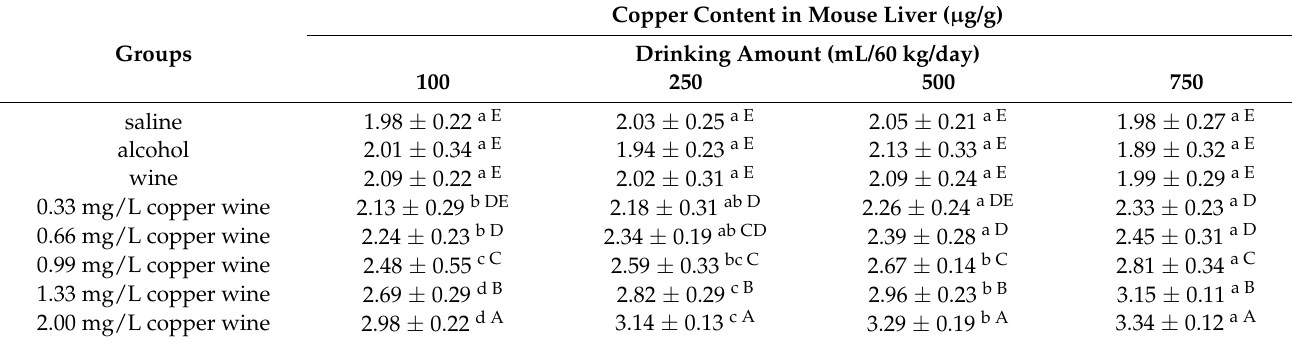
Table 2. The copper content in liver of